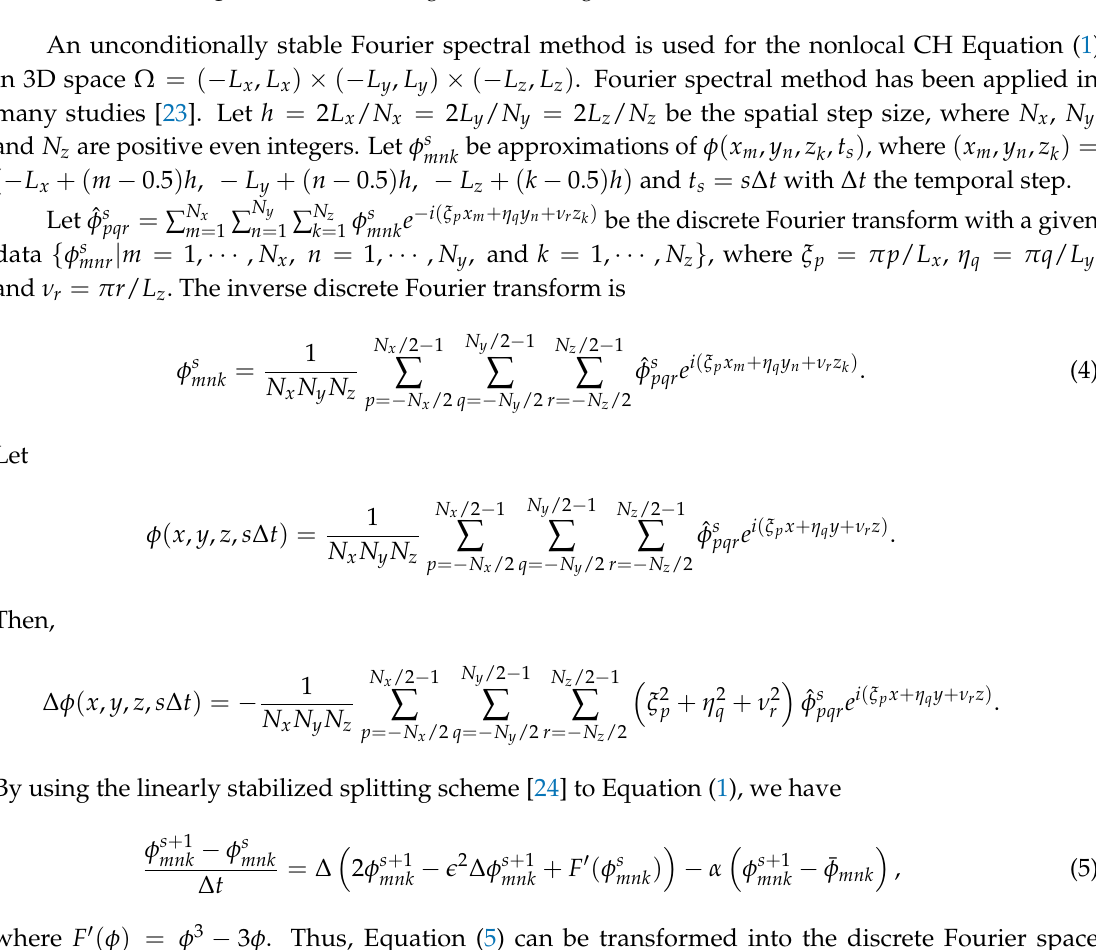
Figure 1. Schematic diagram illustrating a volume in the cubic